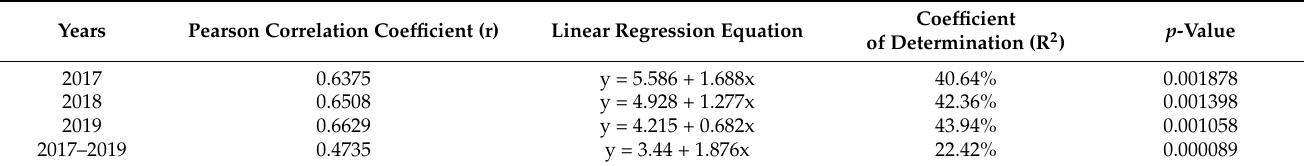
Table 11. Linear relationships between grain yield and phosphorus content in maize leaf blades at BBCH 65.